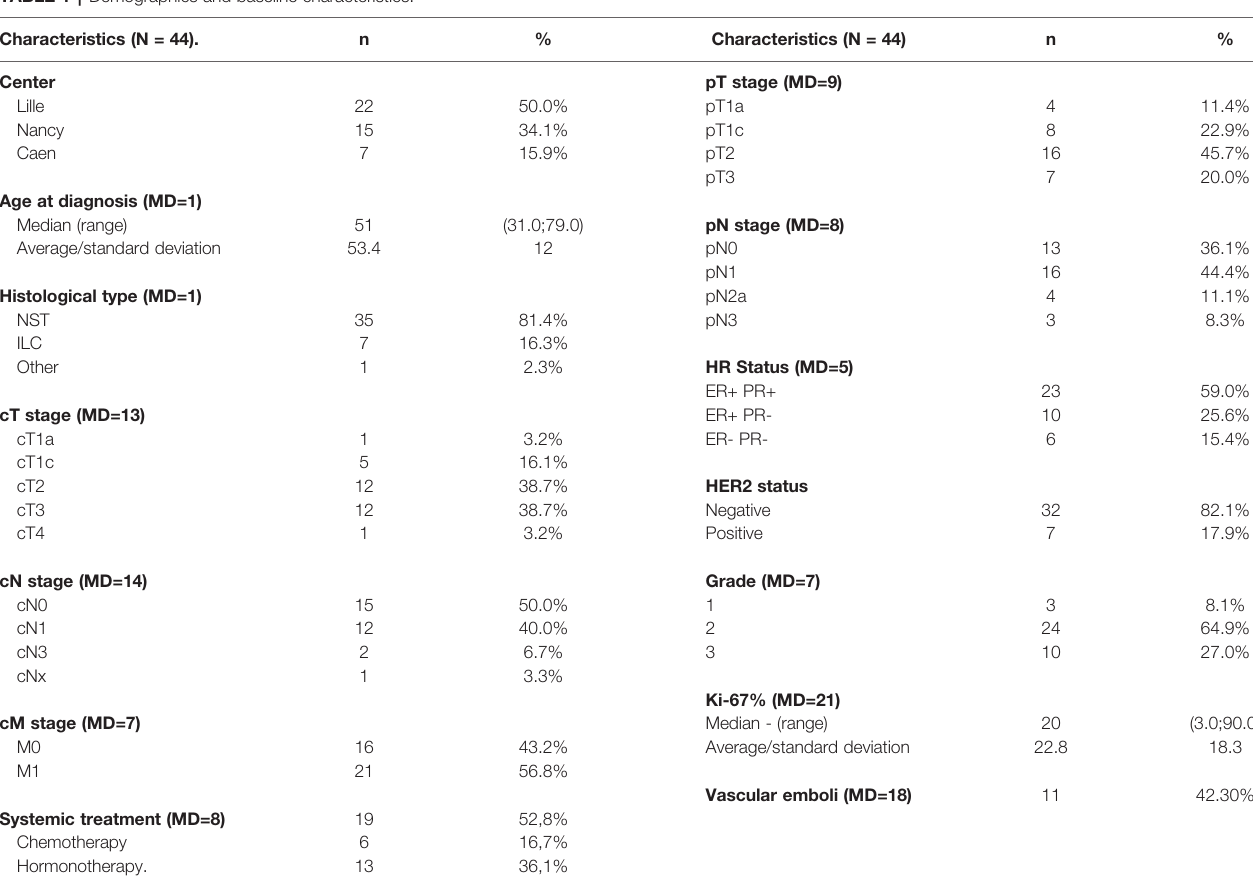
TABLE 1 | Demographics and baseline characteristics. Characteristics (N =